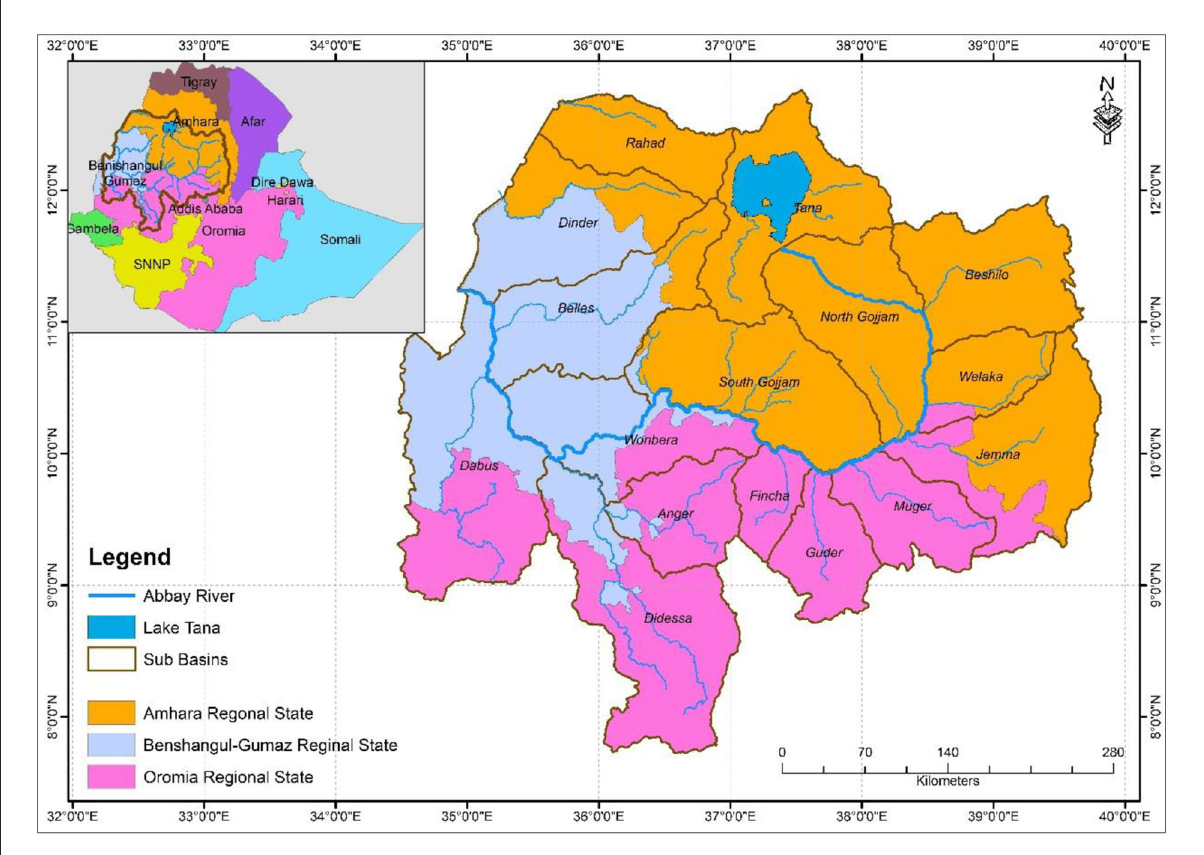
FIGURE2 Sub basins of the Abbay